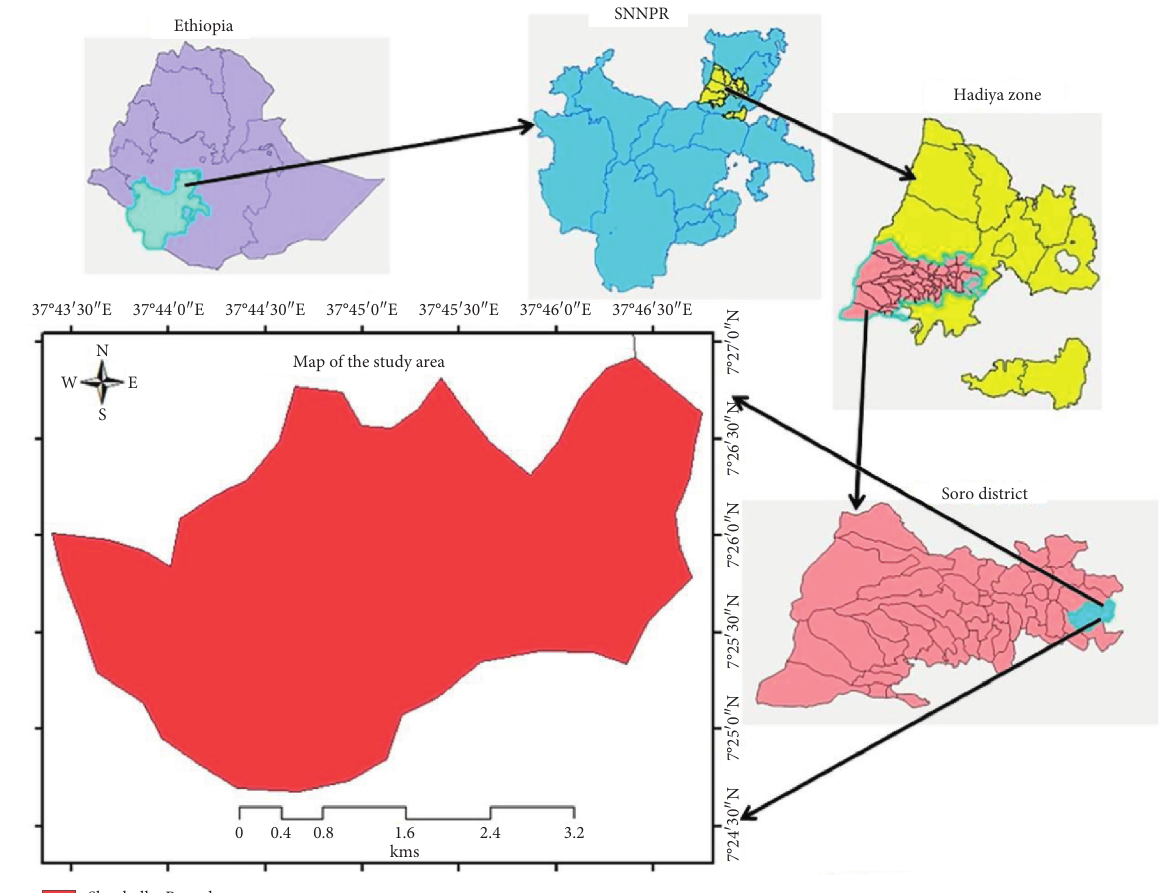
Figure 1: Map of the study site in southern Ethiopia.